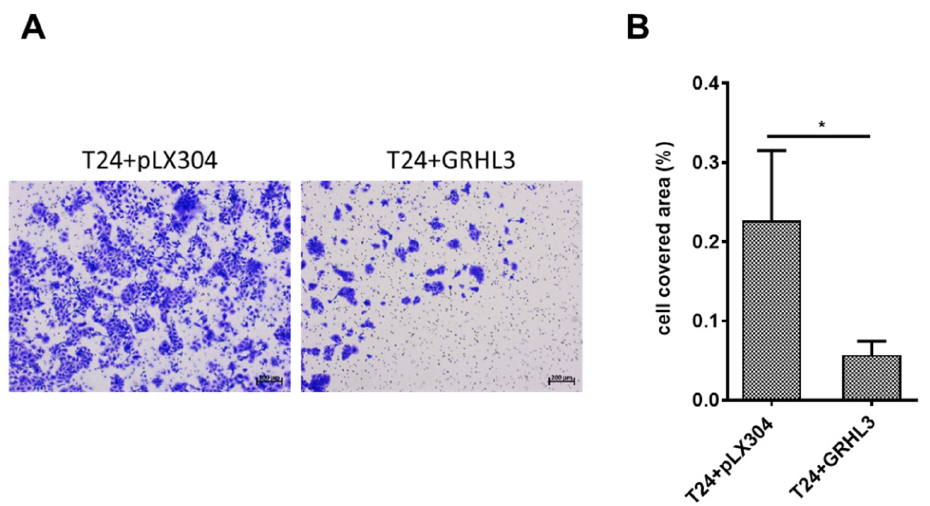
Figure 4. Ectopic overexpression of GRHL3 impairs invasion capacity of T24 cells in Boyden chamber assay. ( A ) Representative images from Boyden chamber assays showing “invaded” T24 cells stained with crystal violet, indicating lower invasive potential in GRHL3-overexpressing cells. Scale bar, 200 µ m. ( B ) Analysis of the cell-covered area using software demonstrated that GRHL3-overexpressing cells (T24 + GRHL3) invaded through membranes to a significantly lower extent than empty vector controls (T24 + pLX304; p = 0.0317). SD bars are shown for a total of 70 images analyzed. * indicates p-value < 0.05.